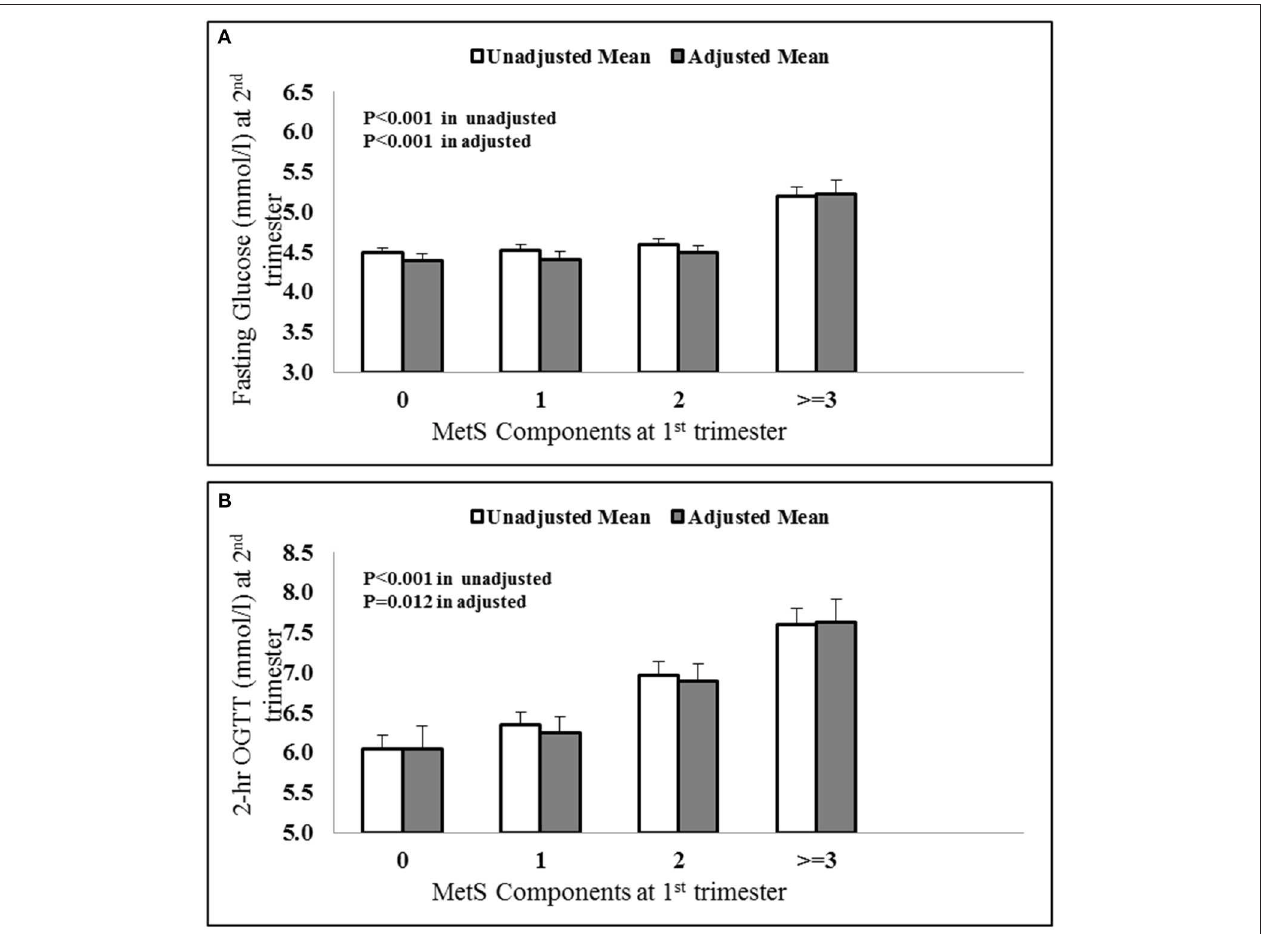
FIGURE 1 | Increasing (A) fasting glucose and (B) OGTT values at 2 nd trimester vs. MetS components at first trimester. The values were adjusted with confounders like age, BMI and parity.